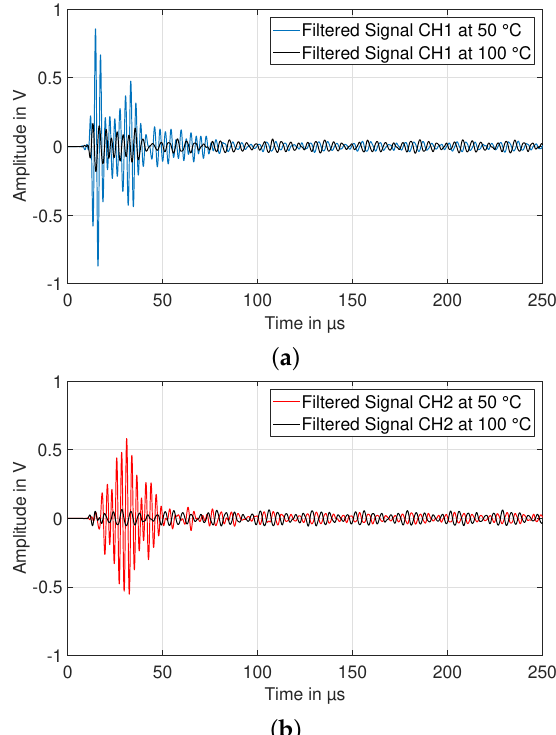
Figure 15. Received signal (amplified and filtered) of in-plane (CH1, ( a )) and through-plane (CH2, ( b )) ultrasonic wave for two different temperature